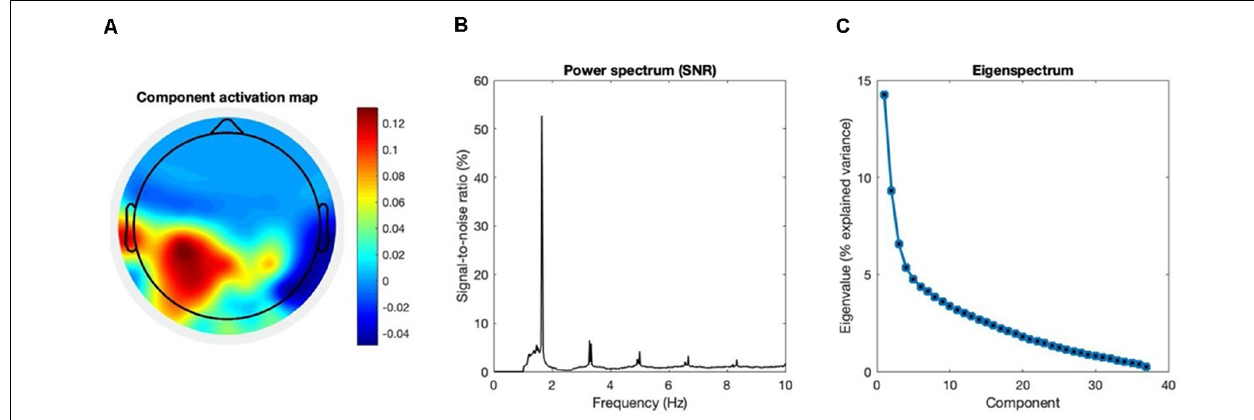
FIGURE 3 | Group-level assessment of the source separation. The following criteria were used to assess the quality of our source separation via generalized eigendecomposition (GED). (A) Topography. The grand-average coefficients of activation are shown in the topographic plot: maximal activation was recorded at the left centroparietal “CP” cluster and at left temporal electrodes (“T7” and “TP7”). It should be noted that we explicitly excluded from the spatial filter the channels located beyond the frontocentral line, for we intended to maximize an entrained response related to sensorimotor processing in the context of the task. (B) SNR spectrum. The grand-average power spectrum is represented here in the percentage signal-to-noise ratio between each data point and the mean power in the neighboring bins (0.5 Hz), in order to remove the physiological 1/f component of the spectrum (Freeman et al., 2003). (C) Eigenspectrum. The grand-average eigenvalues sorted in descending order exhibit a steep exponential decay. The vector of weights w used for our spatial filter is the one associated with the highest eigenvalue λ . Before averaging, eigenvalues were normalized and expressed as percentage of explained variance. All grand-averages were computed on the whole sample of participants (N =